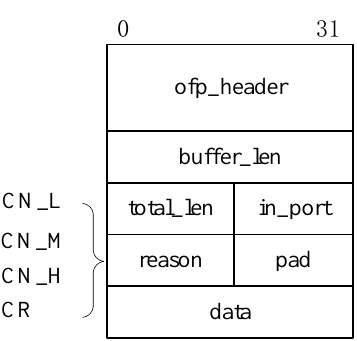
Figure 4. The format of the congestion notification message.